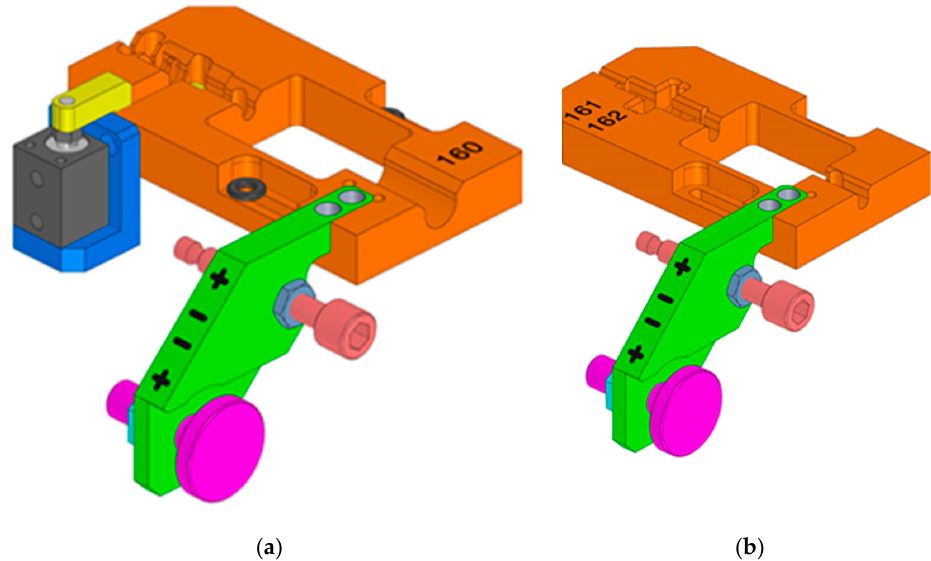
Figure 12. Improved positioning devices for different product references: ( a ) models 159 and 160, ( b ) models 161 and 162.